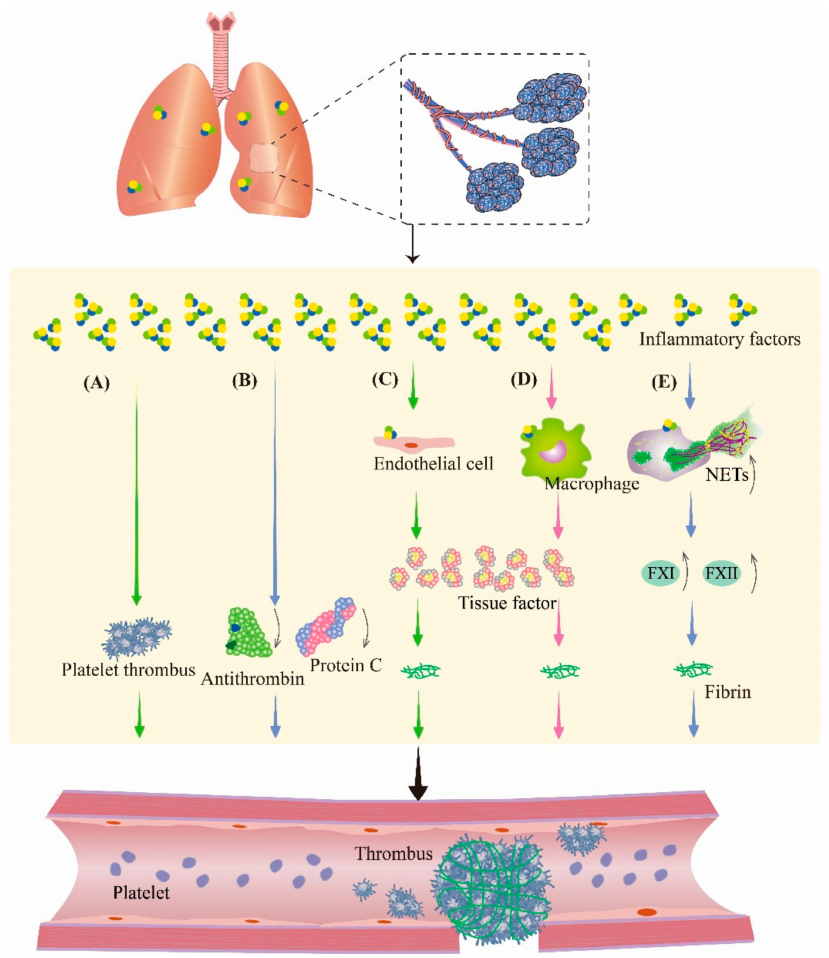
Figure 3. Inflammation aggravates coagulation disorders in PBLI. During inflammation, inflamma- tory factors can promote thrombosis by regulating the coagulation system and fibrinolytic system. ( A ) Inflammatory factors promote platelet activation and aggregation to form platelet thrombosis. ( B ) Inflammatory factors cause the downregulation of antithrombin and protein C to inhibit fibri- nolysis. ( C , D ) Inflammatory factors stimulate endothelial cells and monocytes to produce tissue factor, an activator of coagulation, resulting in fibrinous thrombi. ( E ) Neutrophils are activated